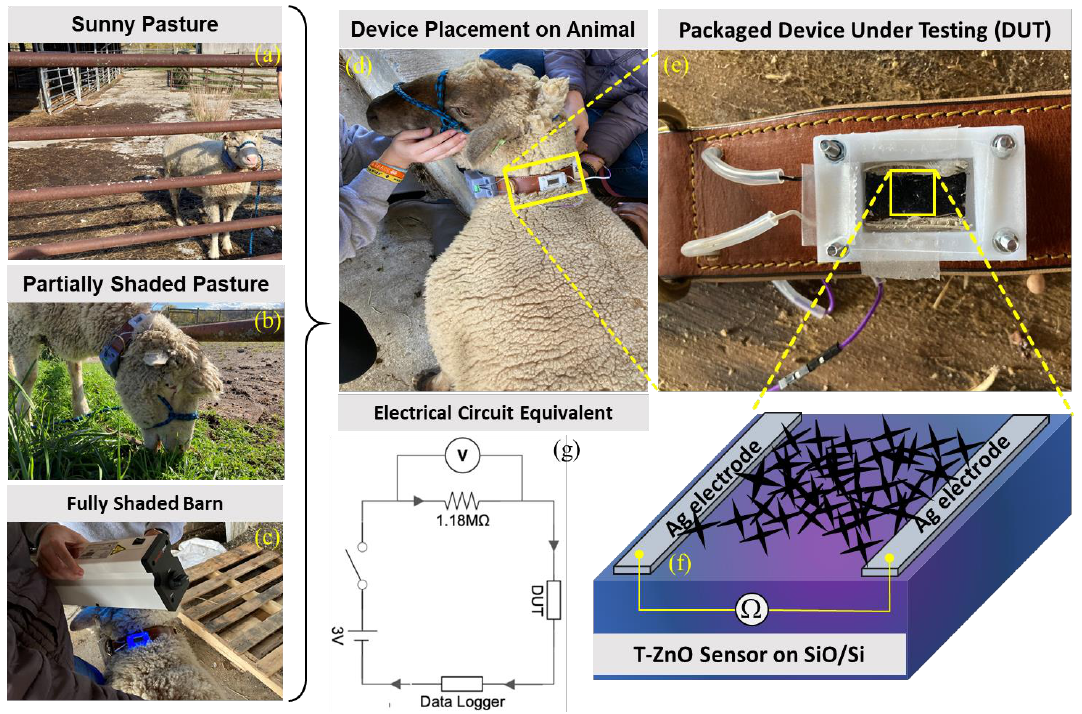
Figure 6. Wearable UV sensor fabricated from T-ZnO on ruminant (sheep) during testing under ( a ) sunny pasture, ( b ) partially shaded pasture, and ( c ) fully shaded barn with ( d ) attached data logger and ( e ) zoomed version, ( f ) schematic of device under test, and ( g ) an equivalent electrical circuit diagram.